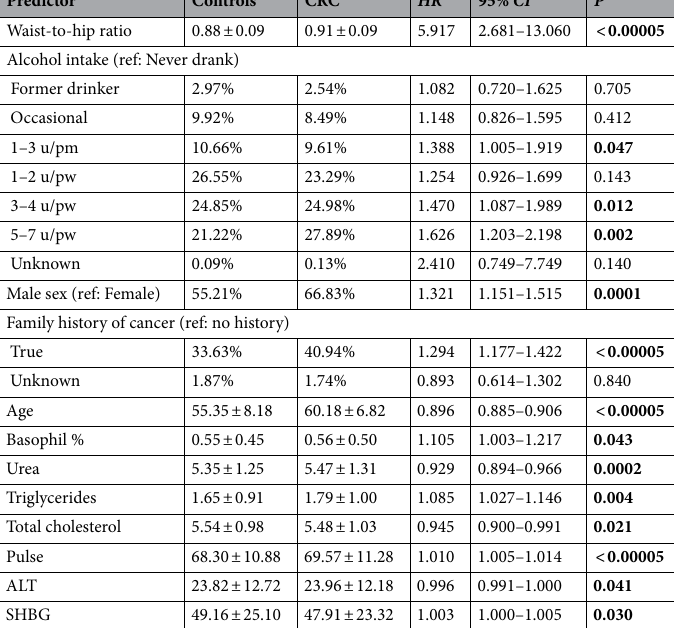
Table 2. Results of the final multivariate Cox PH model in the descending order of the HR magnitude. Columns display the predictor name, the mean or percentage of the predictor for each group, hazard ratio, confidence interval and p value respectively. HRs higher than 1 indicate increase in risk for CRC, whereas HRs lower than 1 indicate a decrease in risk. Significant p-values are displayed in bold. CI confidence interval, HR hazard ratio, ref reference category, SHBG sex hormone binding globulin, u